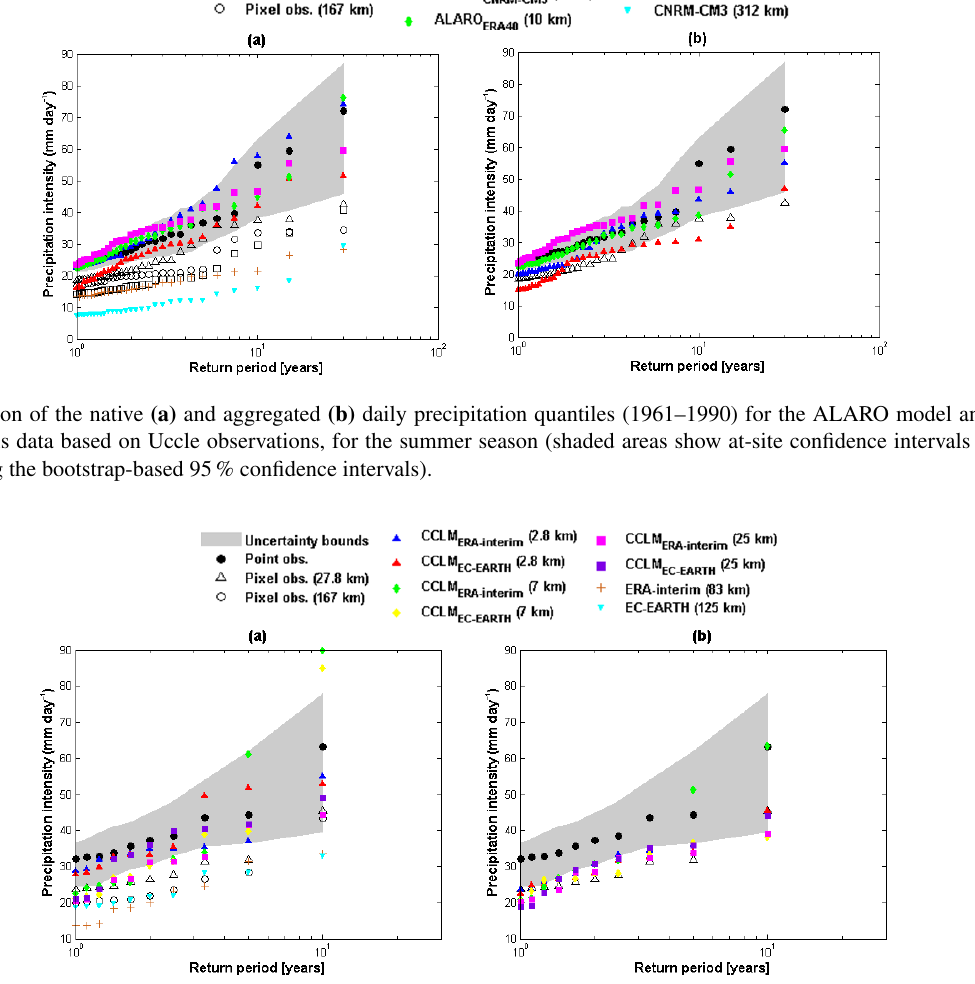
Figure 4. Validation of the native (a) and aggregated (b) daily precipitation quantiles (2001–2010) for the CCLM model and its driving GCM or reanalysis data based on Uccle observations, for the summer season (shaded areas show at-site confidence intervals for the point observations using the bootstrap-based 95% confidence